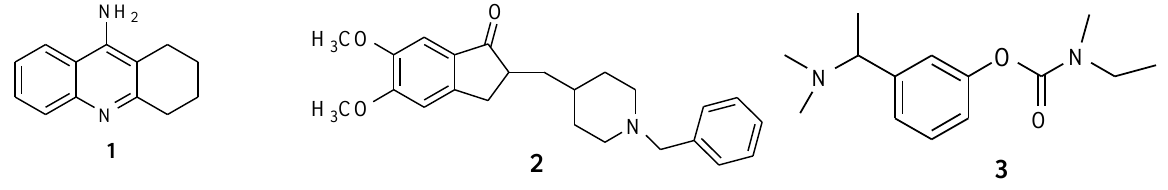
Figure 1. Structures of some acetylcholinesterase inhibitor